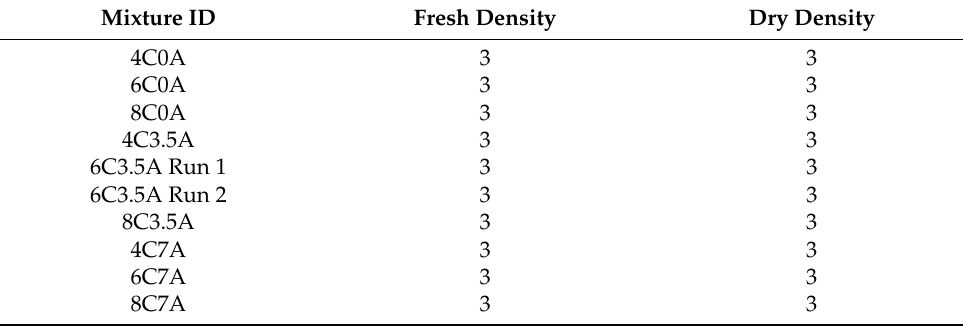
Table 7. Number of backfill specimens tested for fresh and dry density.